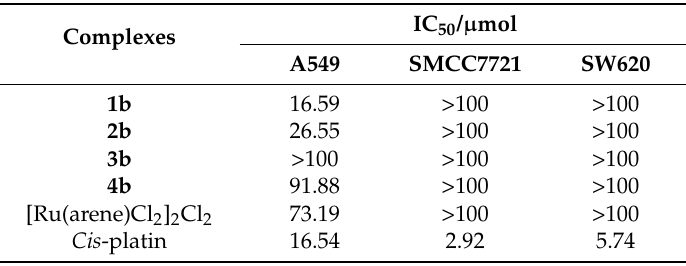
Table 2. The anti-tumor activity of arene Ru(II) complex against various tumor cell lines after 72 h of incubation, determined using the MTT assay. IC 50 / μ mol Complexes